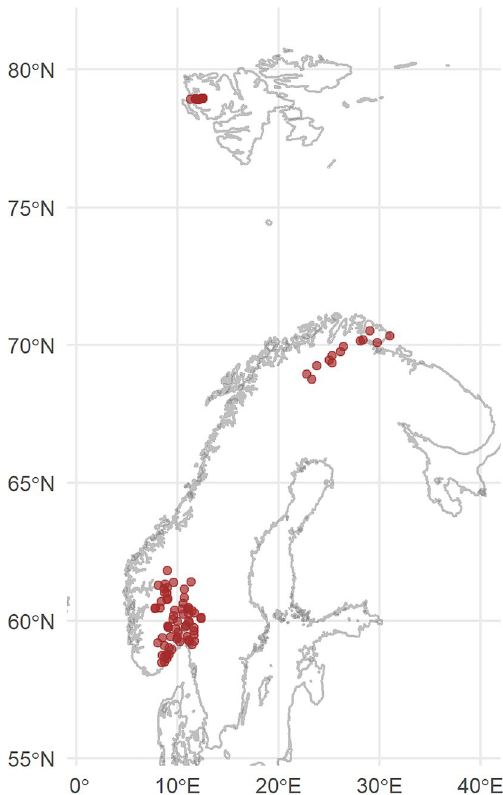
Figure 1. Map of the site locations. The map is generated by R (version 3.4.1): rnaturalearth (https:// cran.r- proje ct. org/ web/ packa ges/ rnatu ralea rth/ README. html) kombined with sf (https:// cran.r- proje ct. org/ web/ packa ges/ sf/ index.